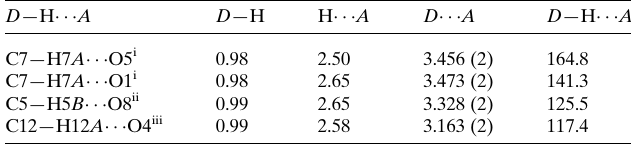
Table 3 Hydrogen bonds and short intermolecular contacts (A˚ , (cid:5) ) for I at 90 K. D —H (cid:2)(cid:2)(cid:2) A